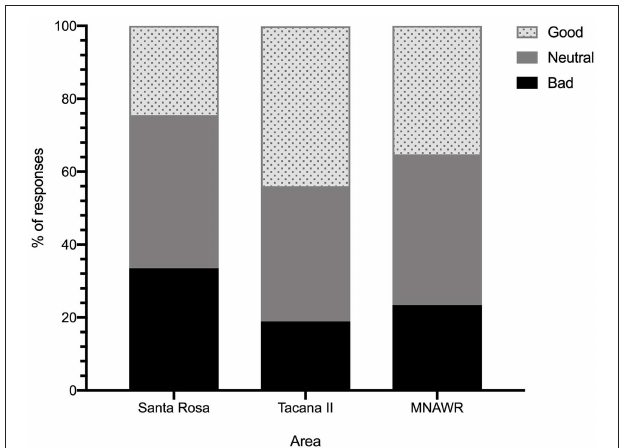
FIGURE 2 | Proportions of attitudes toward jaguar killing, by area.